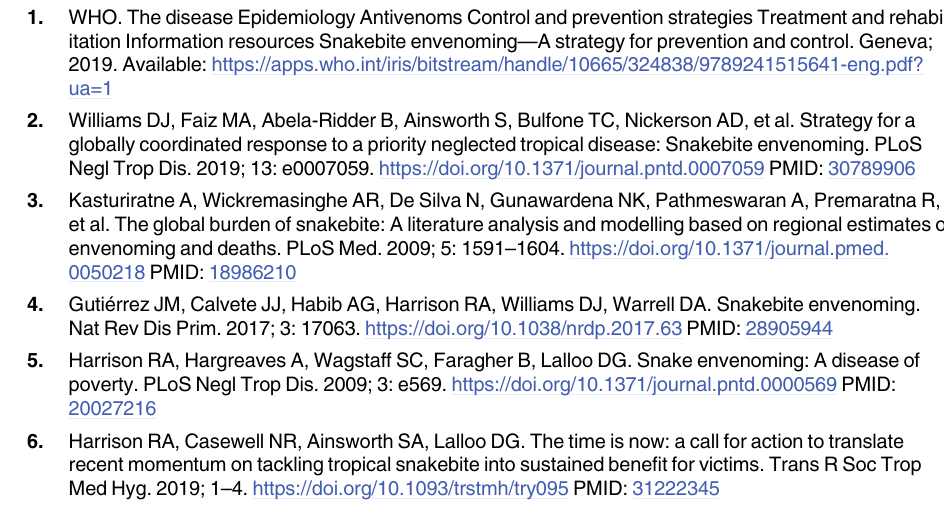
S1 Table. Socio-economic and health system indicators of Burkina